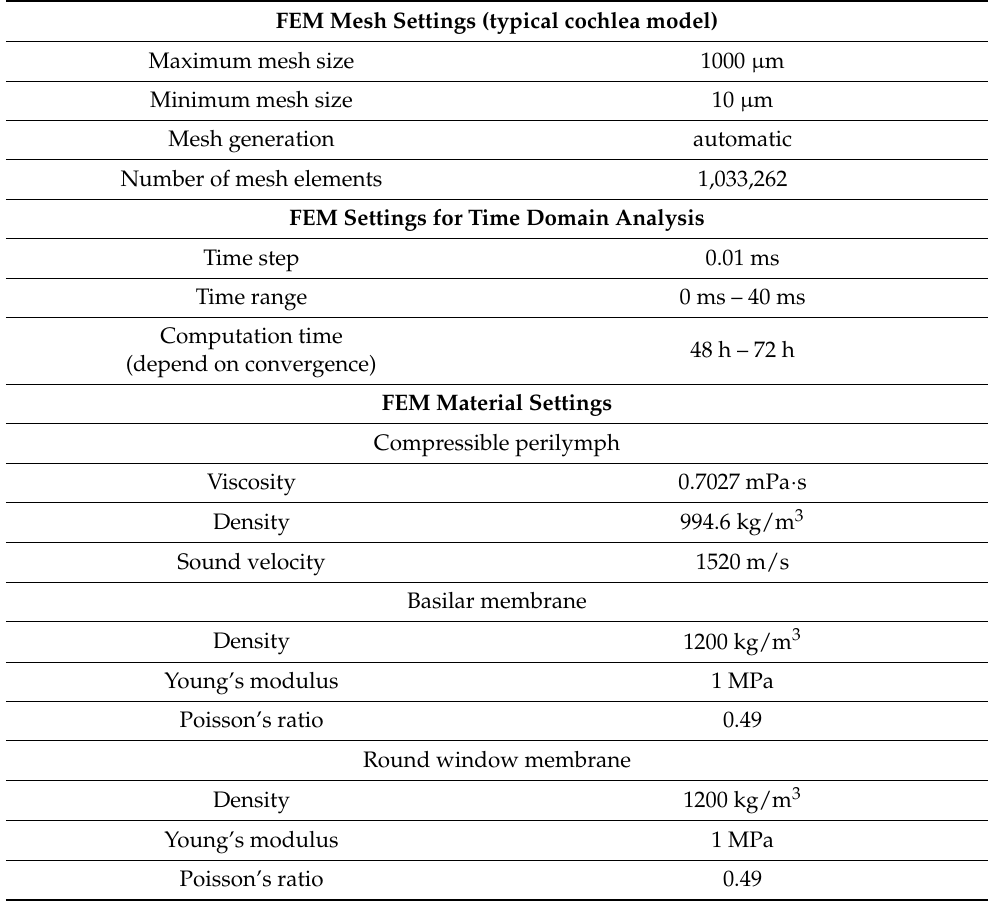
Figure 1. A straight-tapered cochlea model configured by scala vestibuli, scala media, and scala tympani. The scala vestibuli and scala tympani were connected by a helicotrema at the cochlea apex. The scala vestibuli, scala tympani, and helicotrema were filled with compressible perilymph, and a basilar membrane was embedded in the scala media. A continuous sinusoidal plane wave was excited at the oval window. The dimensions were L c = 35 mm, W bc = 1.2 mm, H bc = 2.5 mm, W ac = 0.7 mm, H ac = 1.5 mm, L m = 34 mm, W bm = 100 µm, H bm = 30 µm, W am = 500 µm, H am = 10 µm, D h = 0.65 mm, L a = 3 mm, W a = 1.2 mm, H a = 1.235 mm, W r = 1.12 mm, H r = 0.69 mm, and T r = 70 µm. Table 1. Settings of the finite element method (FEM) simulations and PC